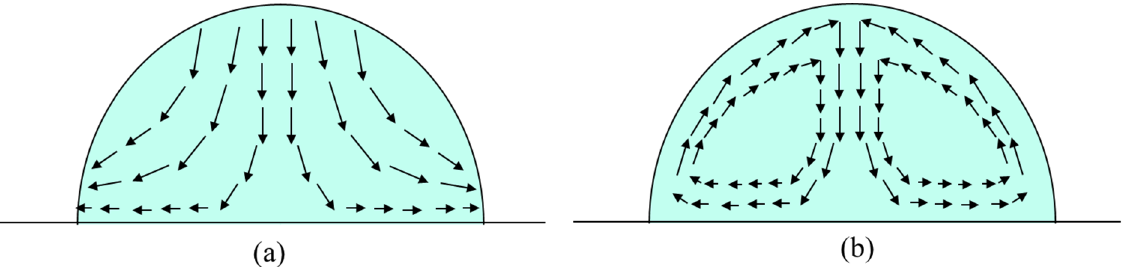
Figure 3. The drying process of a PDMS droplet. ( a ) Fluid flux motion of single-solvent PDMS ink under ambient conditions, ( b ) Fluid flux motion of PDMS ink combined with a co-solvent under ambient conditions.